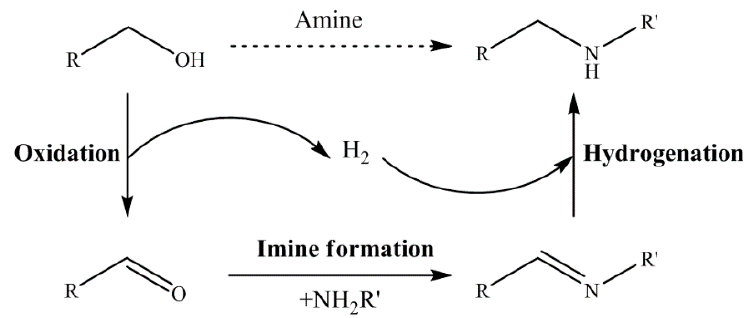
Figure 22. Schematic view of the one-pot alcohols amination applying “hydrogen borrowing approach”, where oxidation in fact stands for dehydrogenation. Reprinted from [123] with permission from Elsevier.